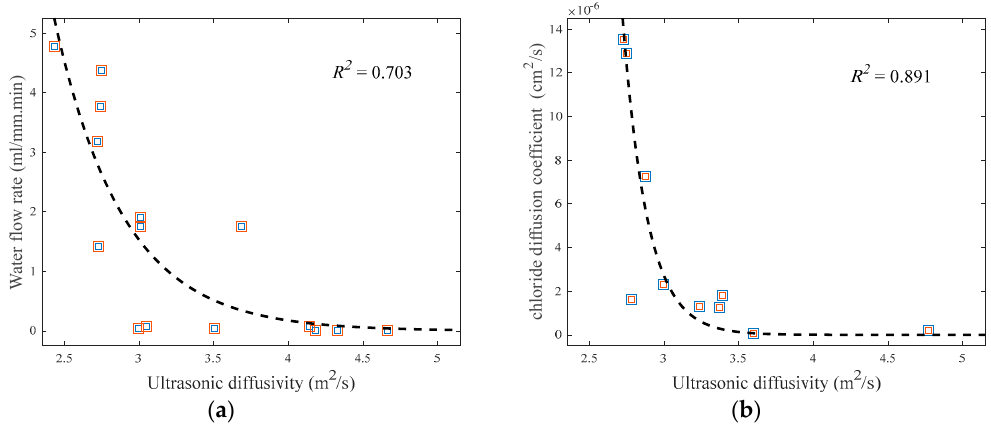
Figure 12. Correlation between the durability properties and ultrasonic diffusivity of cracked concrete: ( a ) Water flow rate; ( b ) Chloride diffusion coefficient.